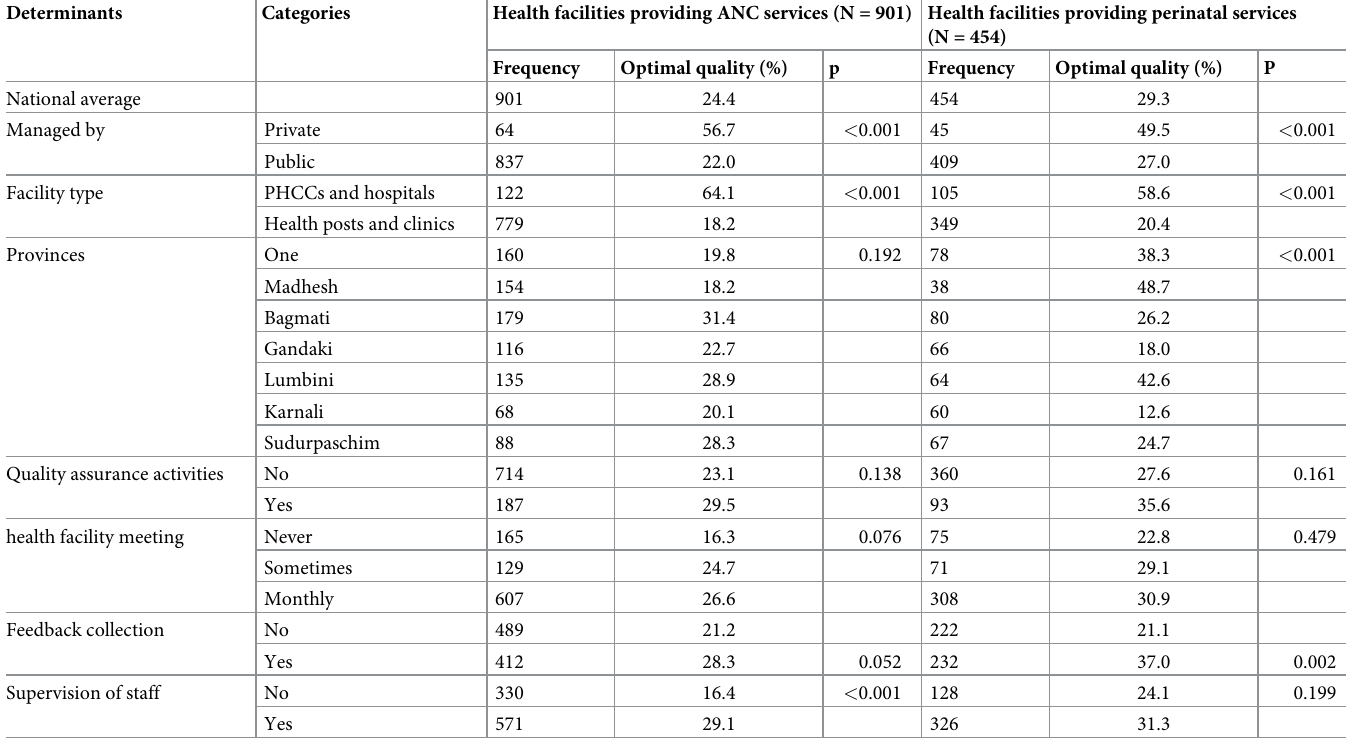
Table 4. Distribution of optimal structural quality of health facilities for routine MNH services in Nepal, 2015. Determinants